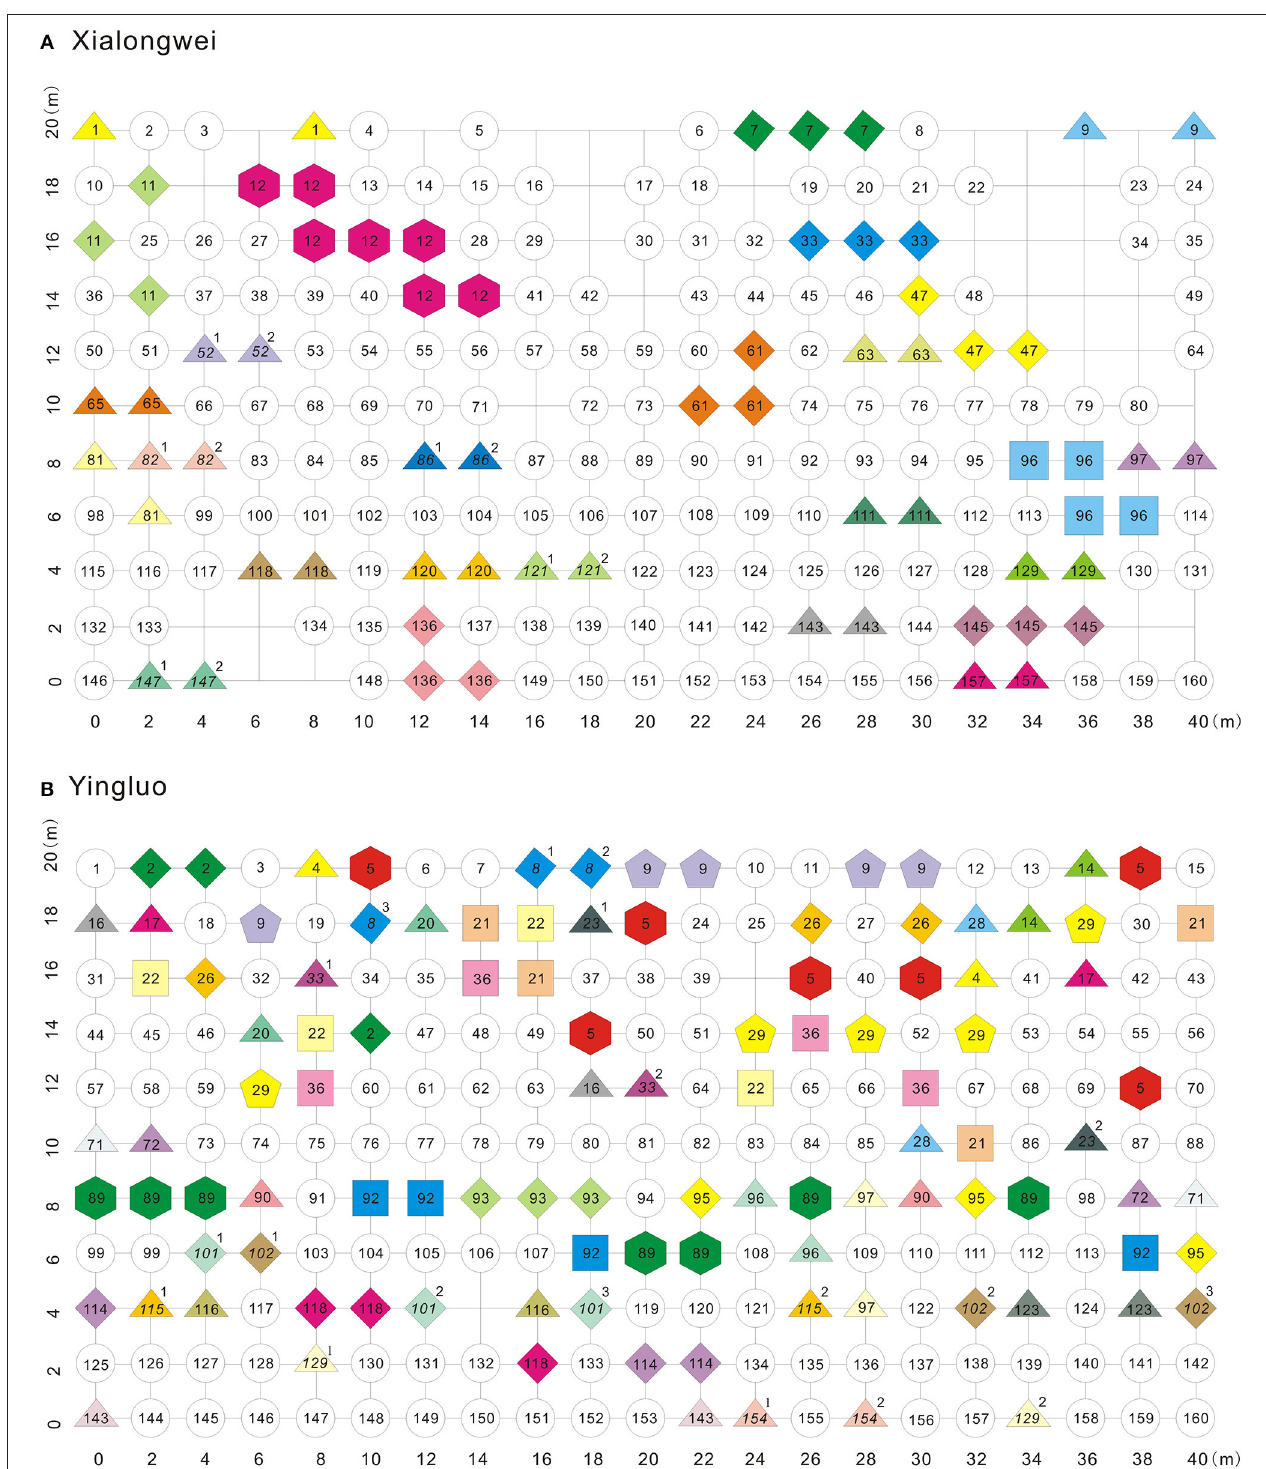
FIGURE 1 | Sampling grids and clone distribution of two Halophila ovalis populations. Circle, triangle, diamond, square, pentagon, and hexagon indicate the clones of 1, 2, 3, 4, 5, and 7 ramets, respectively. The numbers are codes of MLGs. Italic numbers with the superscript of some ramets indicate that they shared the same MLG but were distinct zygotes via distinct sexual events. Same color and same number indicate ramets belonging to the same MLG.